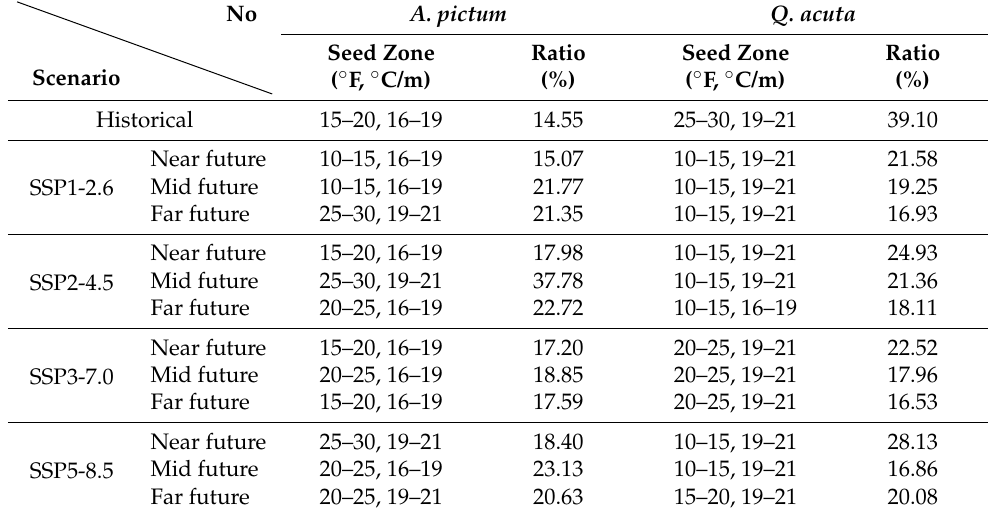
Table 5. Potential high-density zone and ratio in STZs for the future period of the A. pictum and Q. acauta SSP